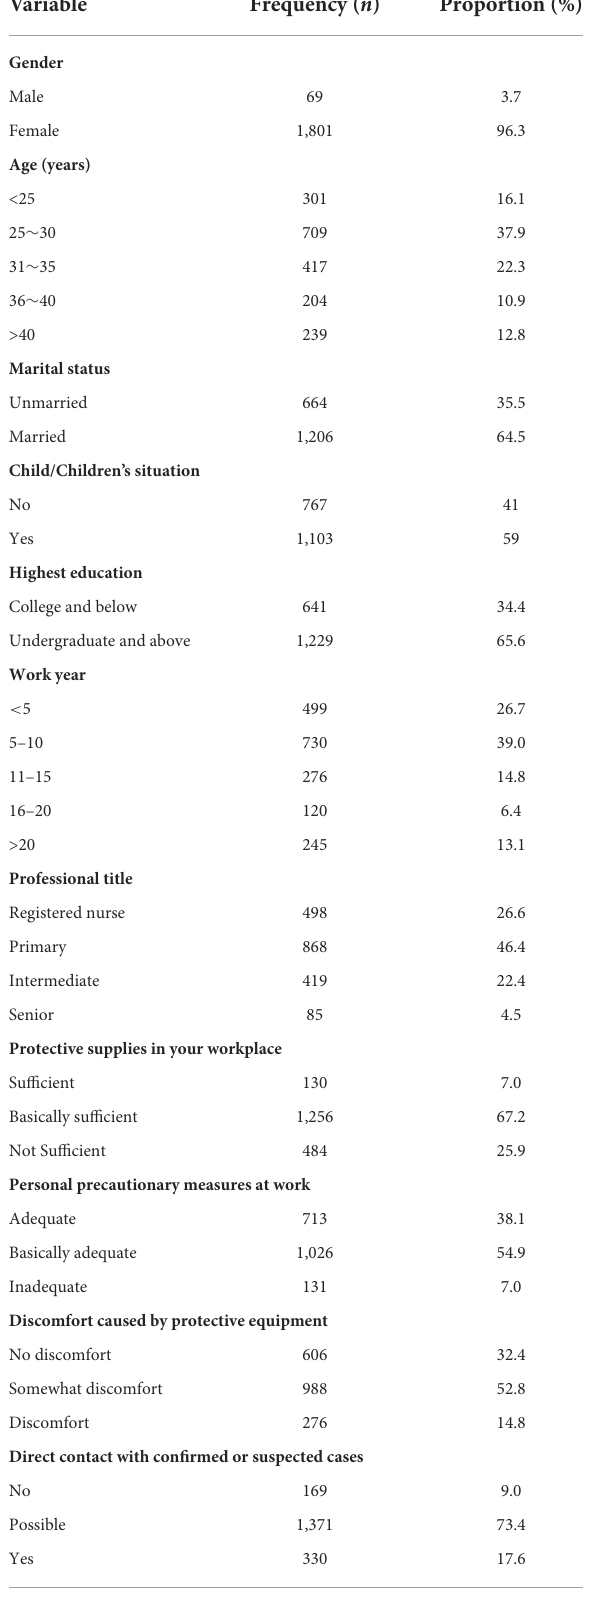
TABLE 1 Characteristics of the subjects ( N =